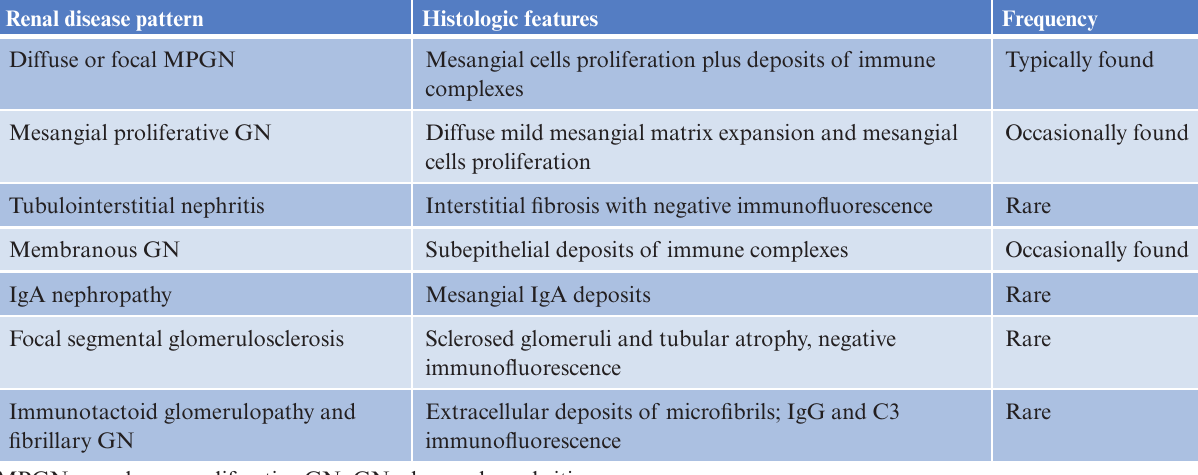
Table 2. Histopathological features of hepatitis C virus-related renal involvement Renal disease